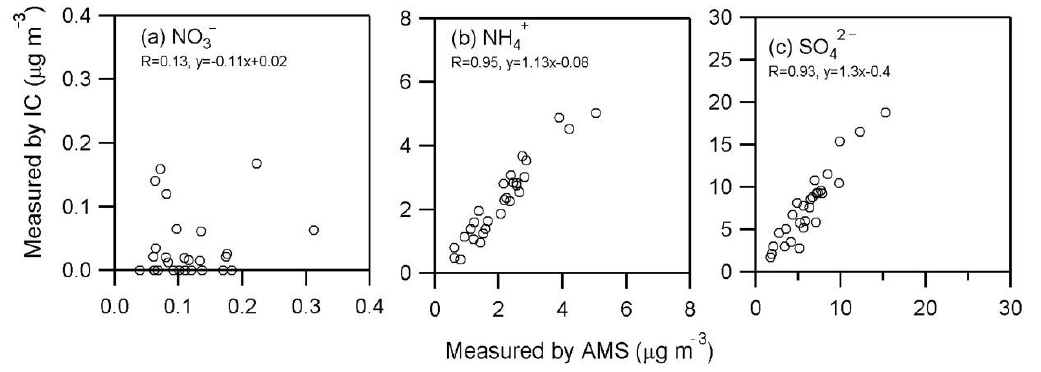
Figure 4. Scatterplots of ( a ) NO 3 − , ( b ) NH 4+ and ( c ) SO 42 − measured by two instruments (IC and AMS) in aerosols collected from Cape Hedo, Okinawa.